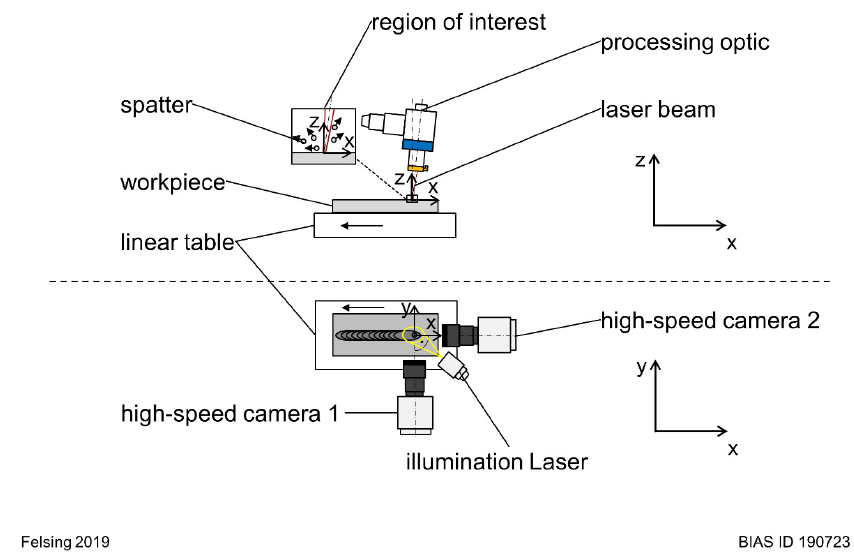
Figure 2. Dual high-speed camera setup for the acquisition of spatter trajectories .